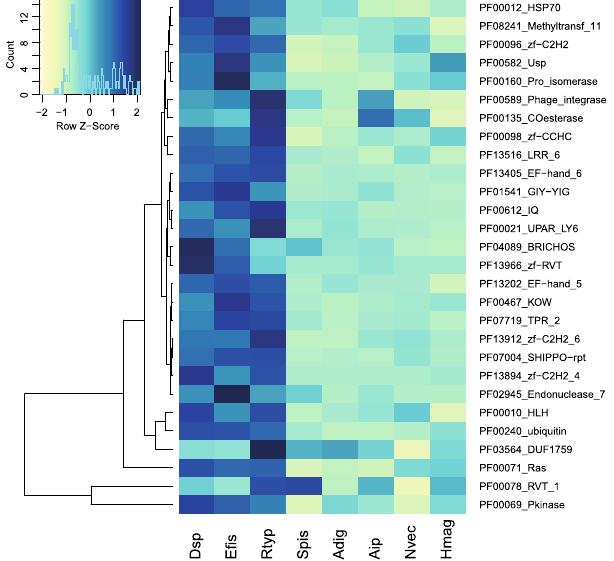
Figure 1. Enrichment of Pfam-based protein domains of three deep-sea coral transcriptomes in comparison to genomic gene sets of other cnidarians. Rows depict Z-score transformed Pfam domain counts and columns represent organisms. Only significantly enriched domains in deep-sea corals are displayed (FDR < 0.05). Rows are clustered by Euclidean distance. Color key indicates domain counts over row z-scores alongside distribution (histogram). Dsp = Dendrophyllia sp., Efis = Eguchipsammia fistula , Rtyp = R . typus , Spis = Stylophora pistillata , Adig = Acropora digitifera , Aip = Aiptasia , Nvec = Nematostella vectensis , Hmag = Hydra magnipapillata